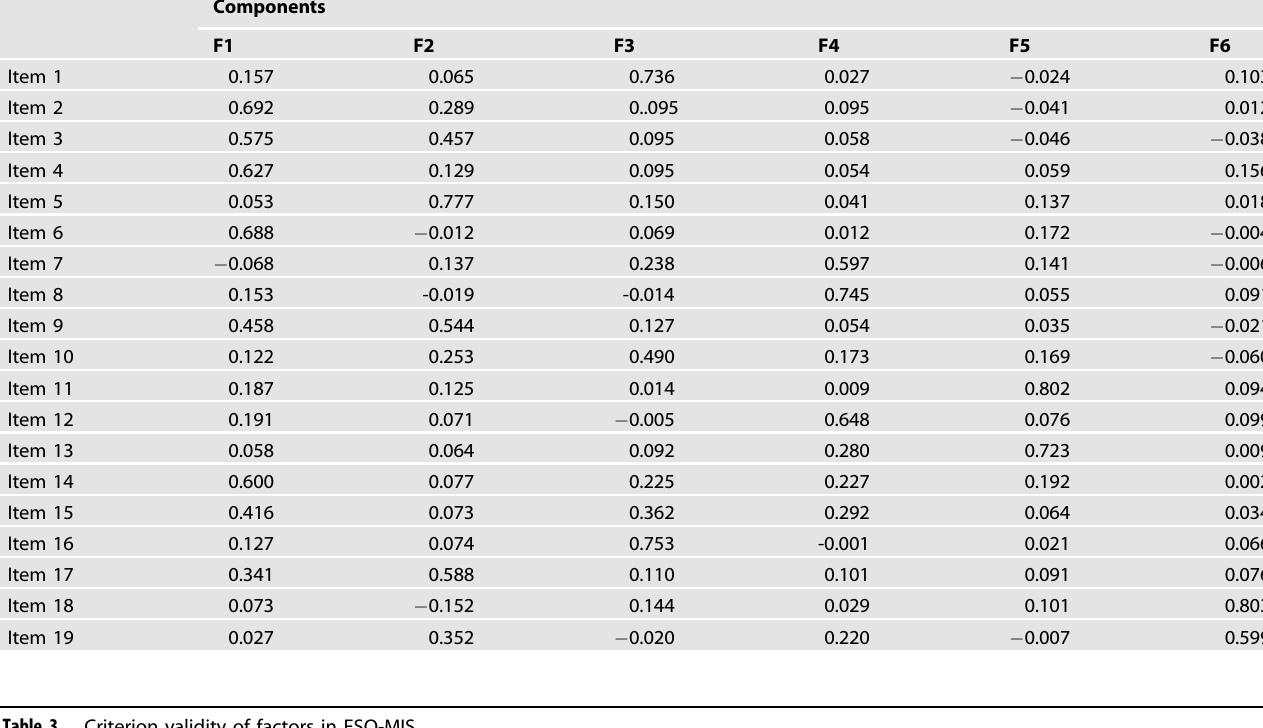
Table 2. Factor analysis matrix of FSQ-MIS.